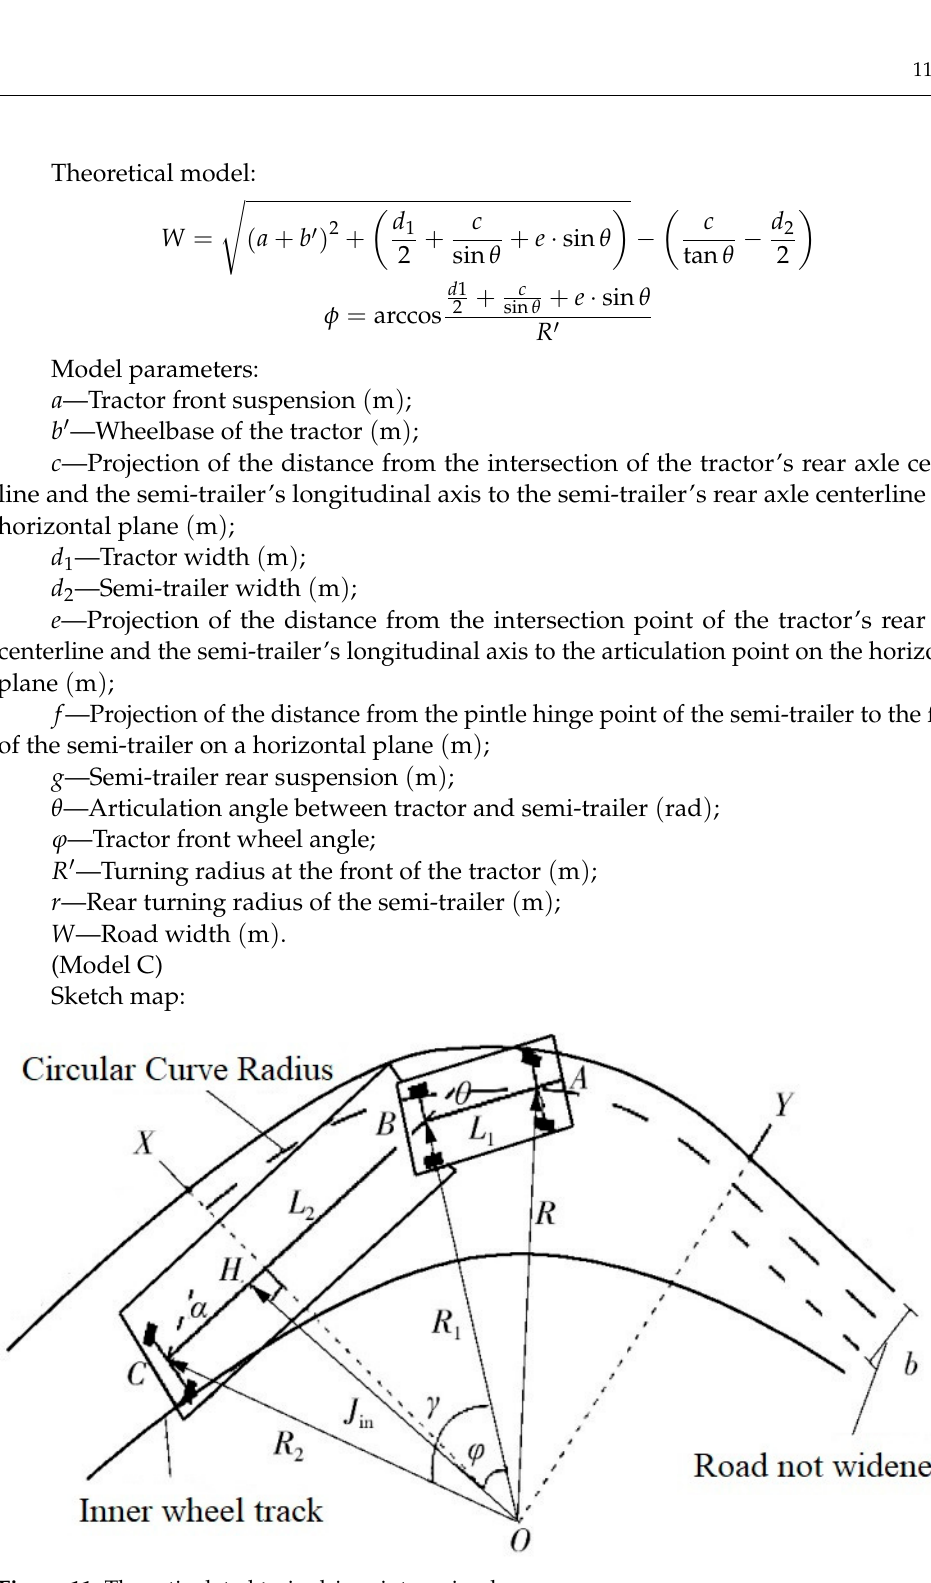
Figure 11. The articulated train drives into a circular curve.